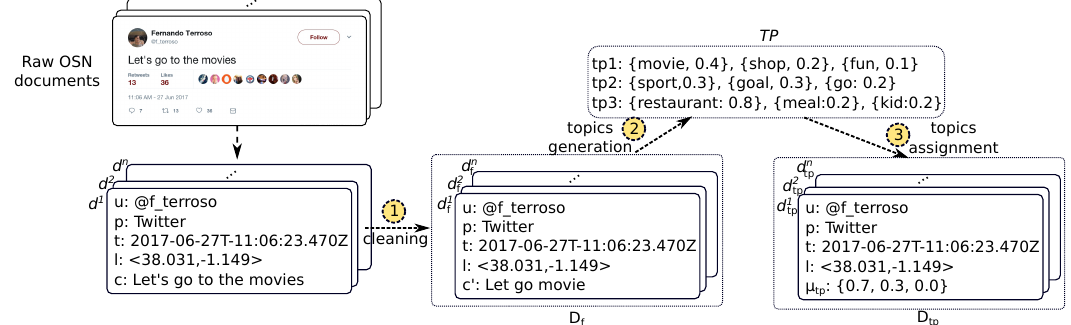
Figure 3. Example of pre-processing of the Online Social Network (OSN)